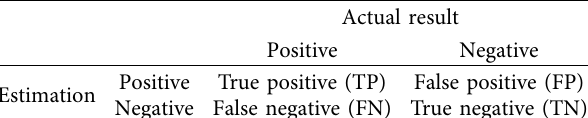
Table 4: Confusion